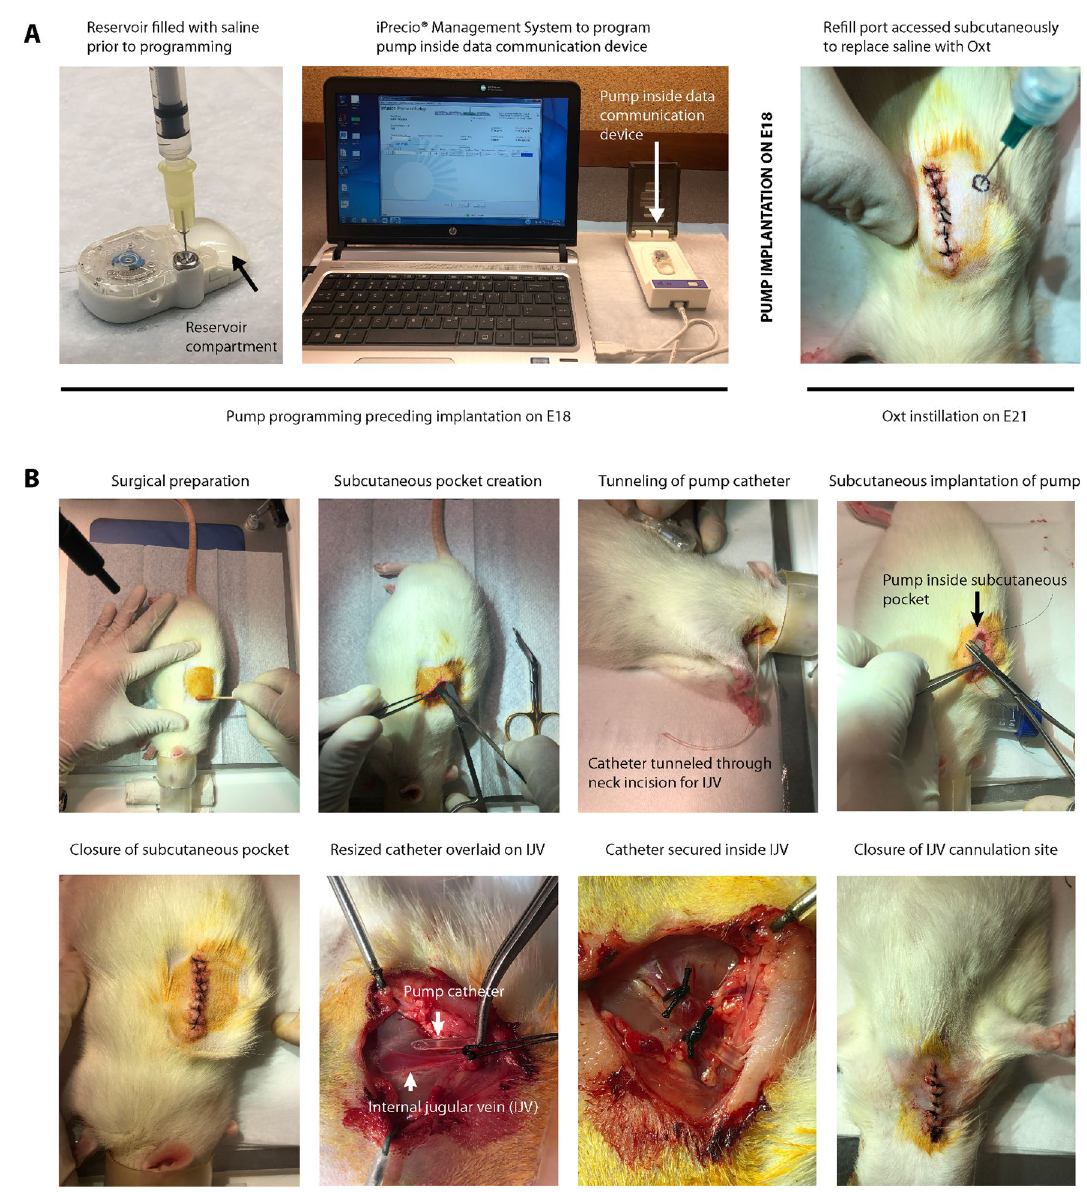
Figure 2. Workflow of experimental and surgical procedures associated with creation of the model. ( A ) Workflow for iPRECIO pump programming prior to implantation on E18 and subsequent replacement of saline with Oxt by subcutaneous access of the refill port on E21. ( B ) Left to right: sequential surgical workflow for implantation of the pre-programmed iPRECIO pump followed by internal jugular vein cannulation with the pump catheter on E18. All surgical procedures were performed in strict accordance with institutional guidelines for rodent surgery, anesthesia, and